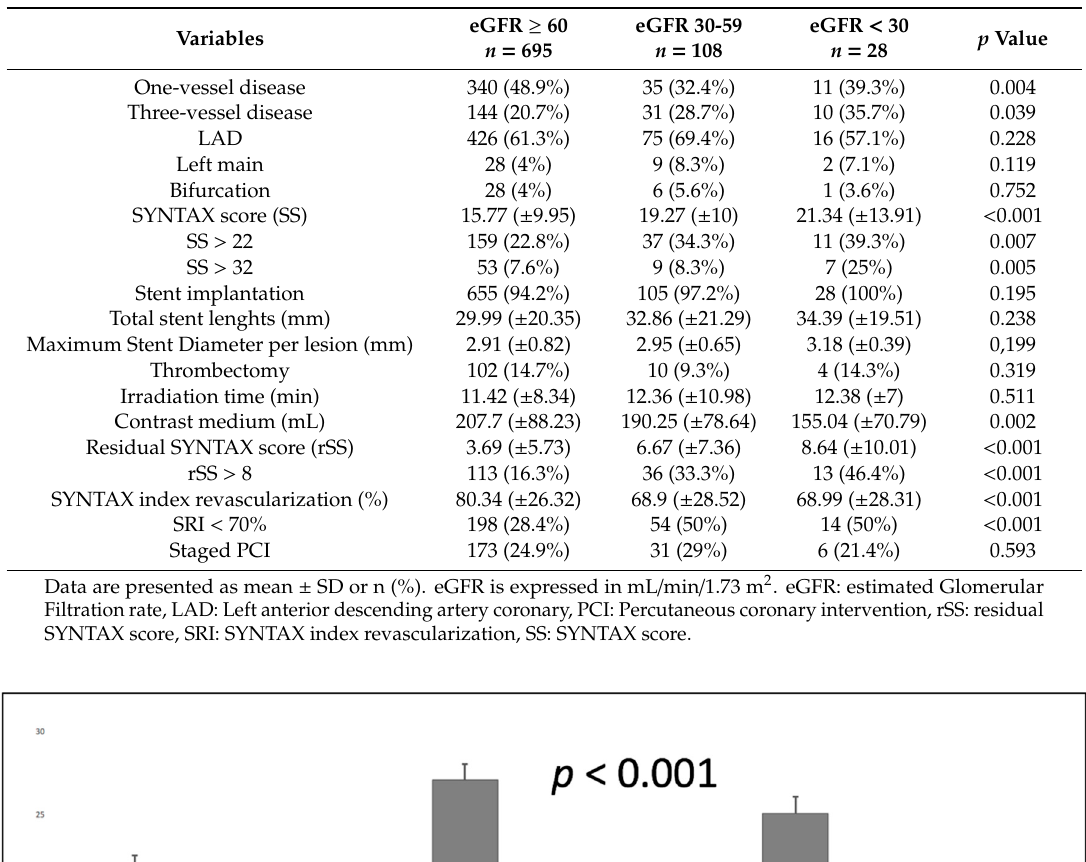
Table 3. Angiographic and PCI procedure characteristics according to renal function.